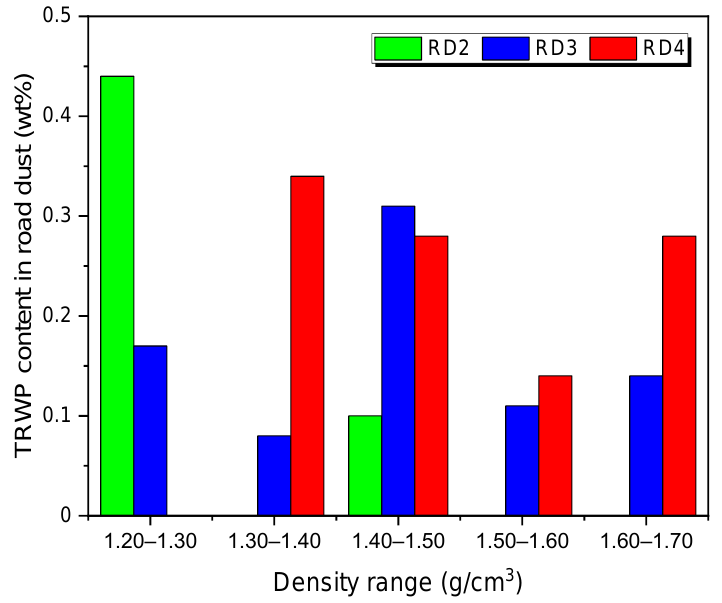
Figure 7. Variations in the TRWP contents in the road dust samples with the TRWP density.